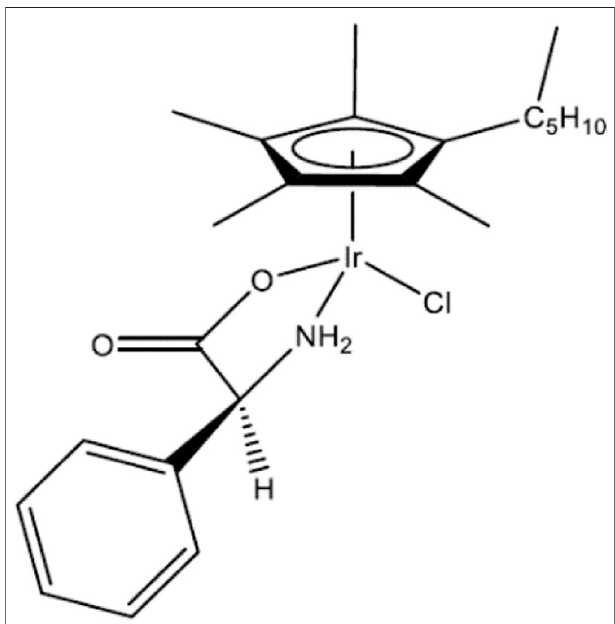
FIGURE 1 | Structure of 1-PG . ( η 5 -pentamethylcyclopentadienyl) (phenylglycine) chloroiridium.